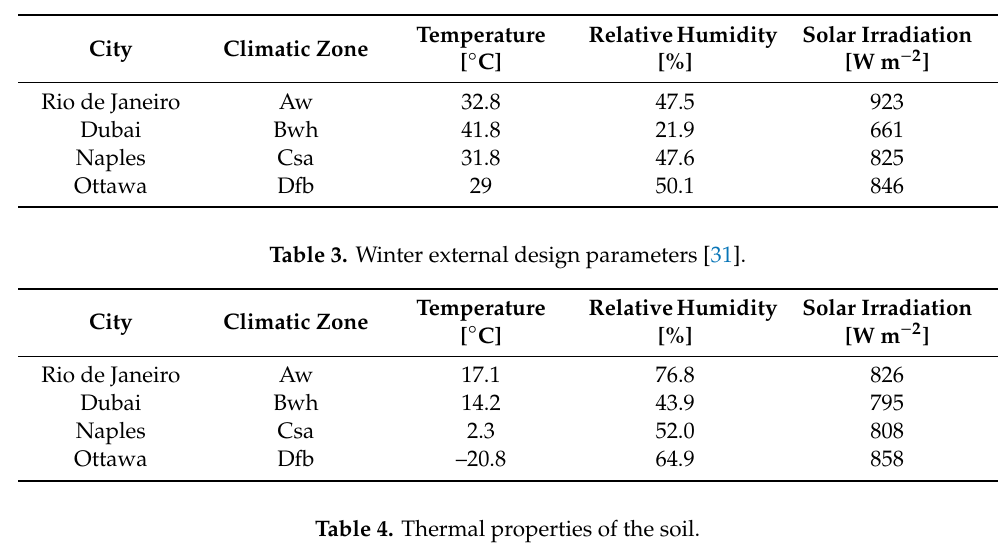
Table 2. Summer external design parameters [31].